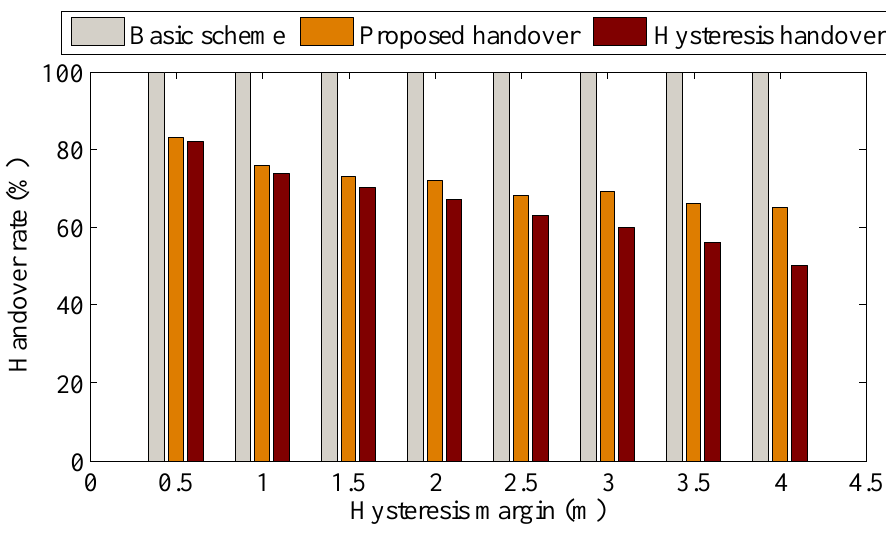
Figure 10. Comparison of handover rate in the BSN deployment case with constructive